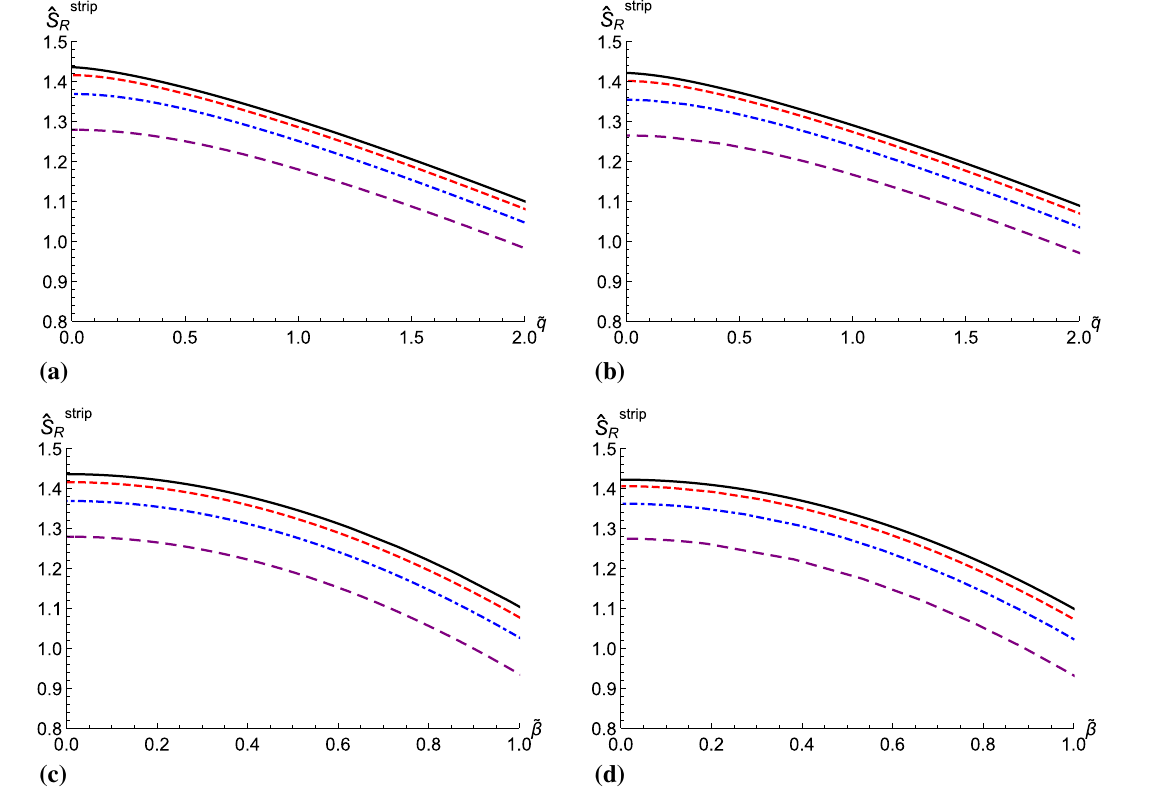
Fig. 3 The refined function ˆ S strip for a ˜ β = 0, b ˜ β = 0 . 2, c ˜ q = 0 and d ˜ q = 0 . 2. These curves represent the lines on the surfaces in Fig.2 and R correspond to the temperatures ˜ T = 0(Solid), 0.1 (Shortdashed), 0.15 (Dotdashed) and 0.2